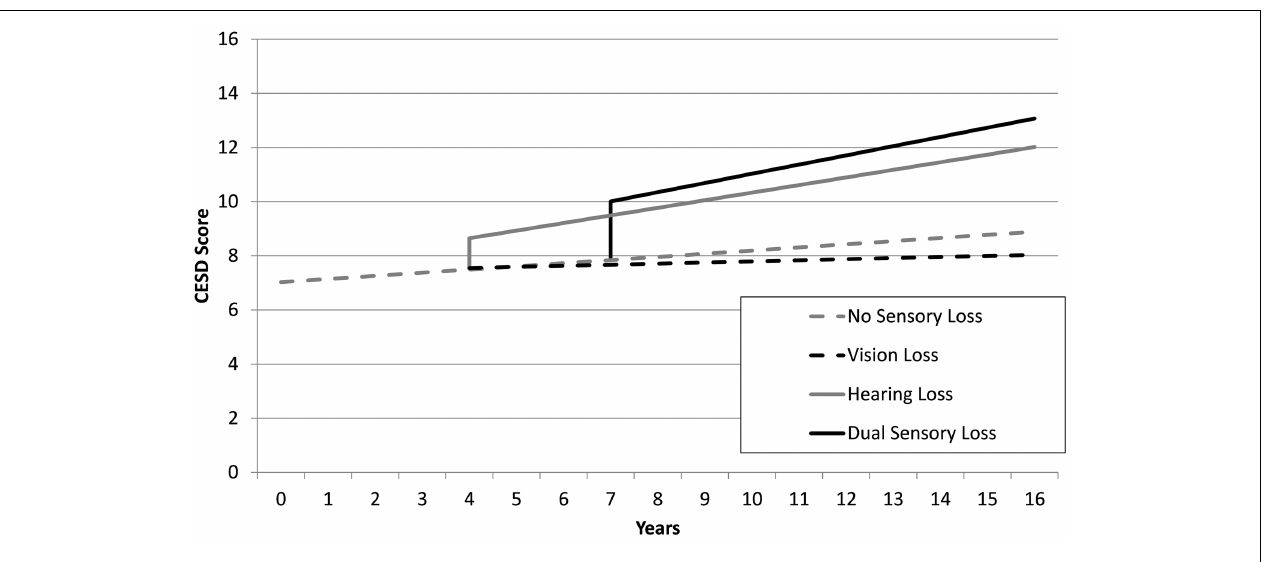
FIGURE 1 | Mean trajectories estimated from unadjusted linear-mixed models, depicting discontinuities in levels and rates of change of CES-D scores as a function of sensory loss for four hypothetical scenarios: no